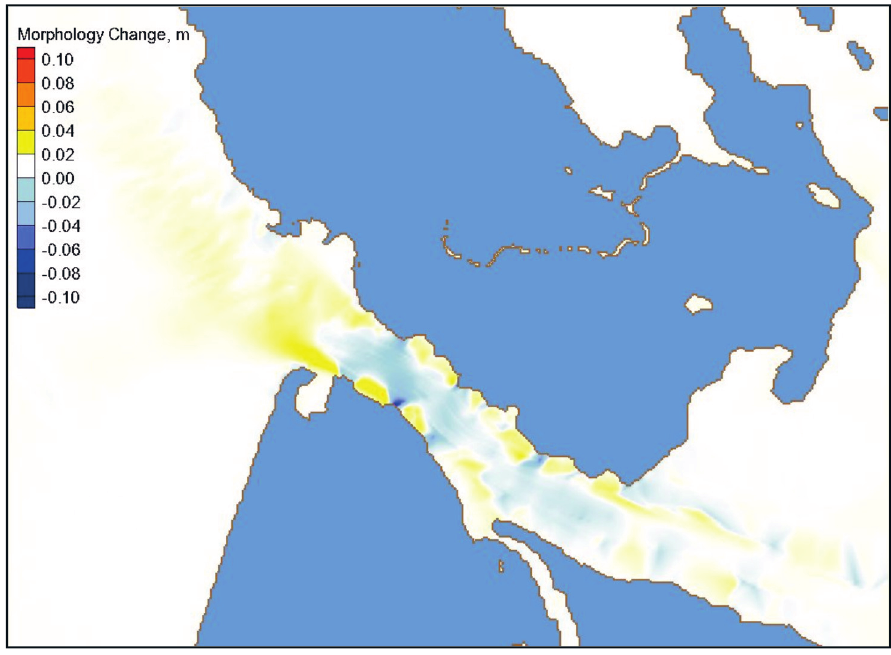
Figure 31. Model sediment accretion and erosion for the existing configuration under Hurricane